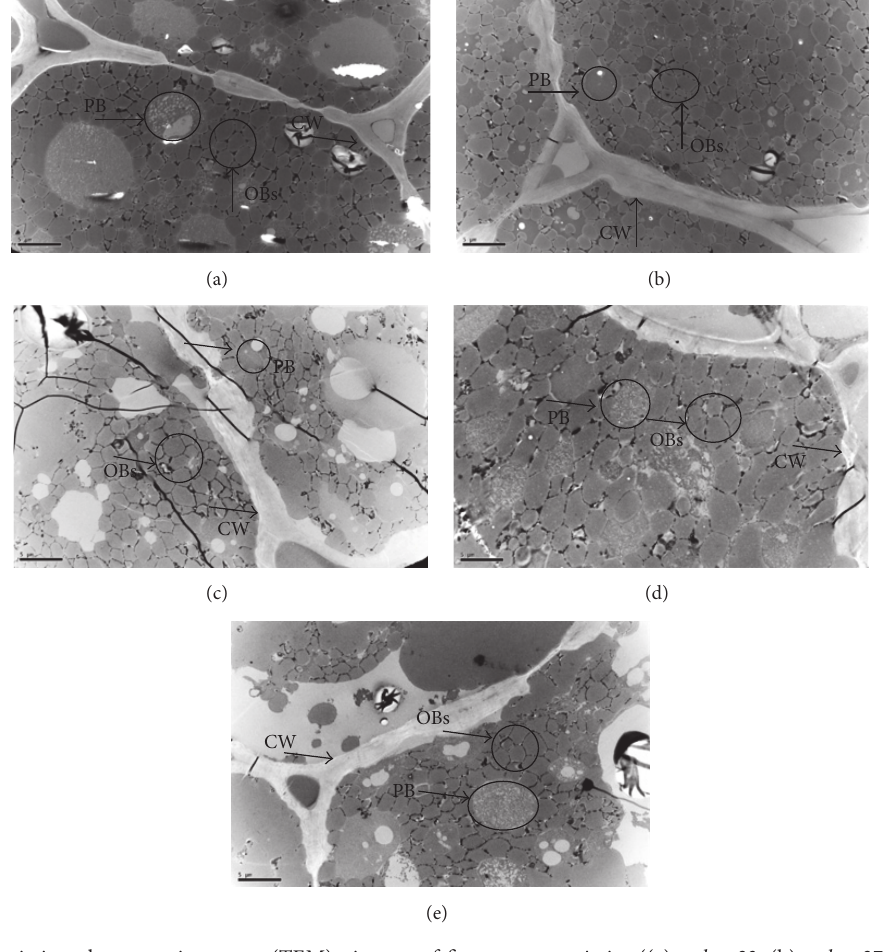
Figure 1: The transmission electron microscope (TEM) pictures of five peanut varieties ((a) yuhua23 , (b) yuhua27 , (c) yuhua9719 , (d) yuhua9830 , and (e) yuhua9502 ). Bar represents 5 𝜇 m (PB, protein body; CW, cell wall; OBs, oil